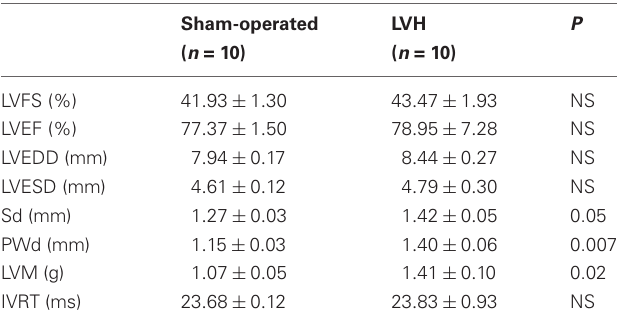
Table 2 | Echocardiographic characteristics in sham-operated and LV hypertrophy